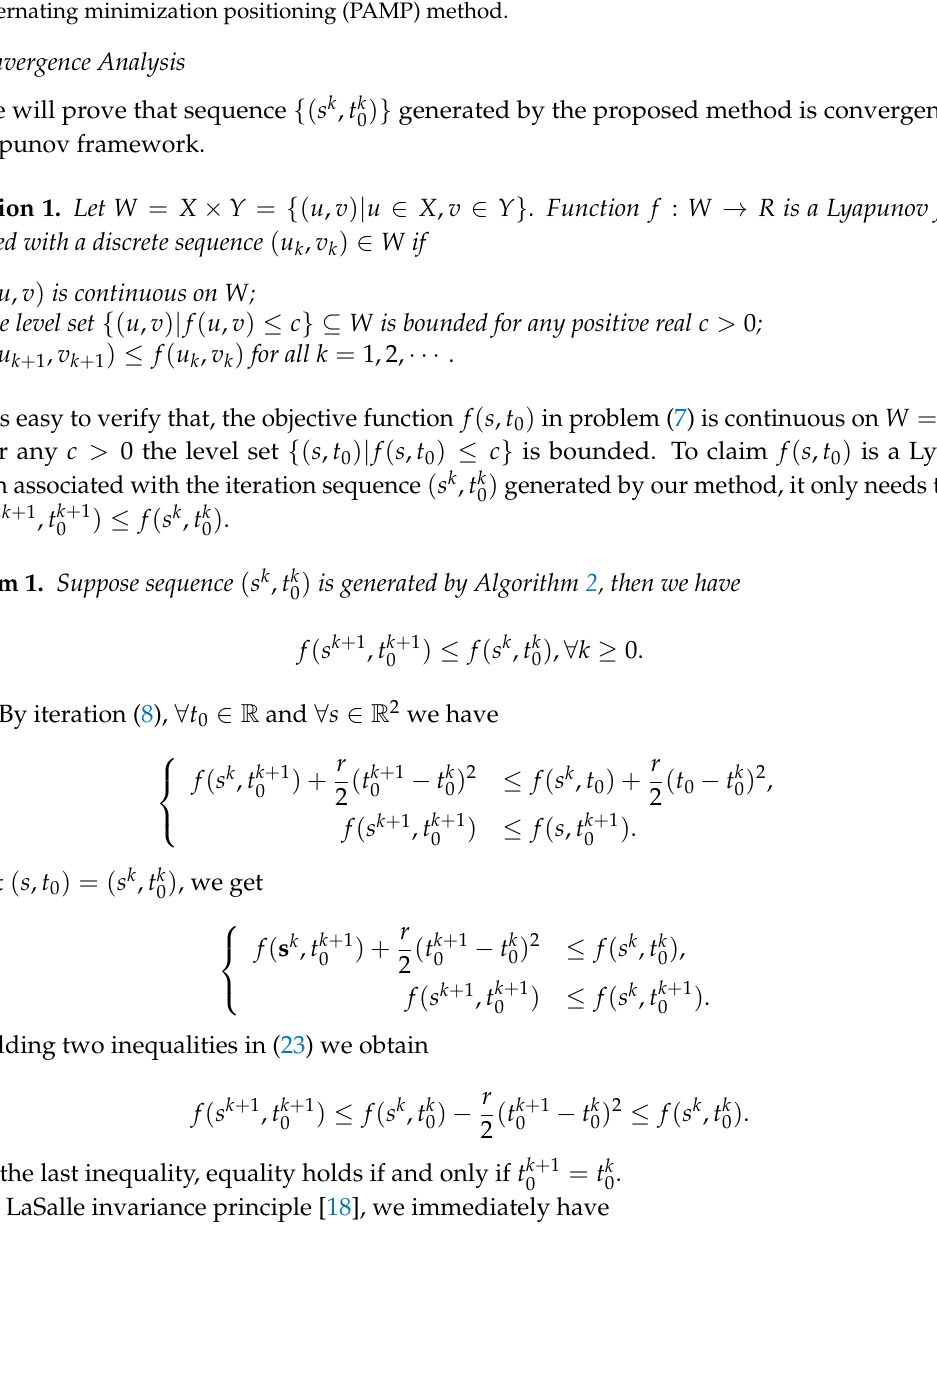
Figure 2. The flowchart for solving asynchronous source localization problem by the proximal alternating minimization positioning (PAMP)